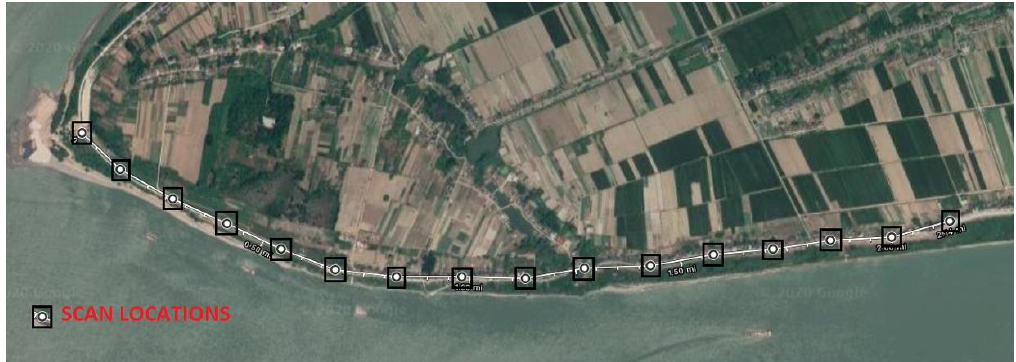
Figure 11. Scan locations.